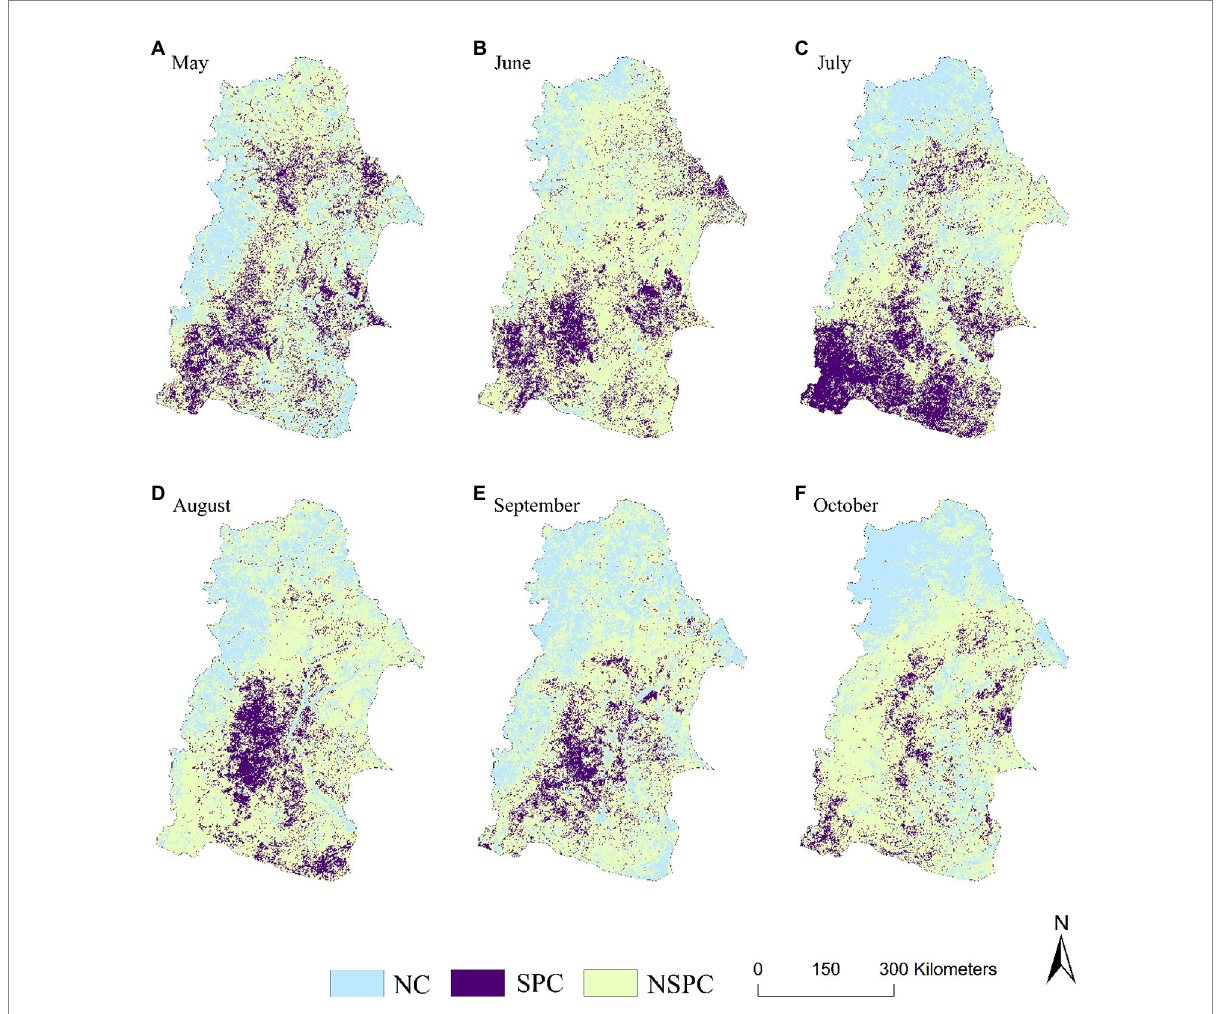
FIGURE 4 Spatial distribution of correlative level between the NDVI and SPEI same period effect at the monthly scale. NC: Negative correlation; SPC: Significant positive correlation; NSPC: Not significant positive correlation; the same